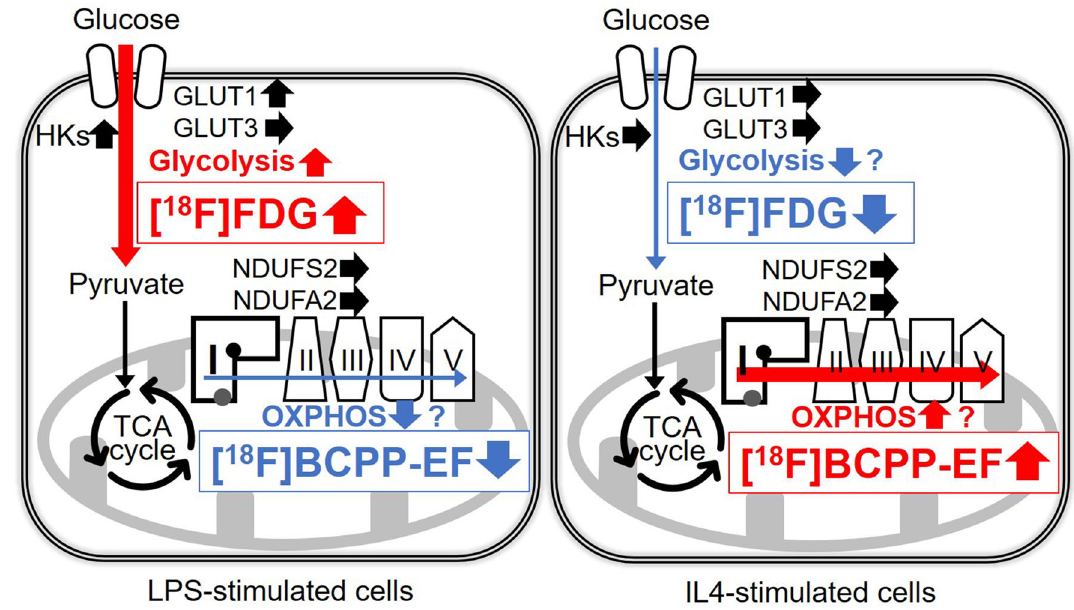
Figure 6. Putative changes in [ 18 F]FDG and [ 18 F]BCPP-EF uptake and metabolic profiles in LPS- or IL4- stimulated microglia. In LPS-stimulated microglial cells, overexpression of glycolysis-related genes (GLUT1 and HK2) was observed in the present study, and glycolysis and oxidative phosphorylation (OXPHOS) activity were previously reported to be increased and decreased, respectively. [ 14 C]2DG ([ 18 F]FDG) and [ 18 F]BCPP-EF uptake were increased and decreased according to these changes in metabolic profiles, respectively, and the [ 18 F]BCPP-EF/[ 14 C]2DG ([ 18 F]BCPP-EF/[ 18 F]FDG) ratio was decreased. In IL4-stimulated microglial cells, glycolysis and OXPHOS activity were speculated to be decreased and increased, respectively, without a change in gene expression. [ 14 C]2DG ([ 18 F]FDG) and [ 18 F]BCPP-EF uptake was decreased and increased according to previously reported changes in metabolic activity profiles, respectively, and the [ 18 F]BCPP-EF/[ 14 C]DG ([ 18 F] BCPP-EF/[ 18 F]FDG) ratio was increased. The red and blue arrows indicate increased and decreased expression, activity, or uptake,